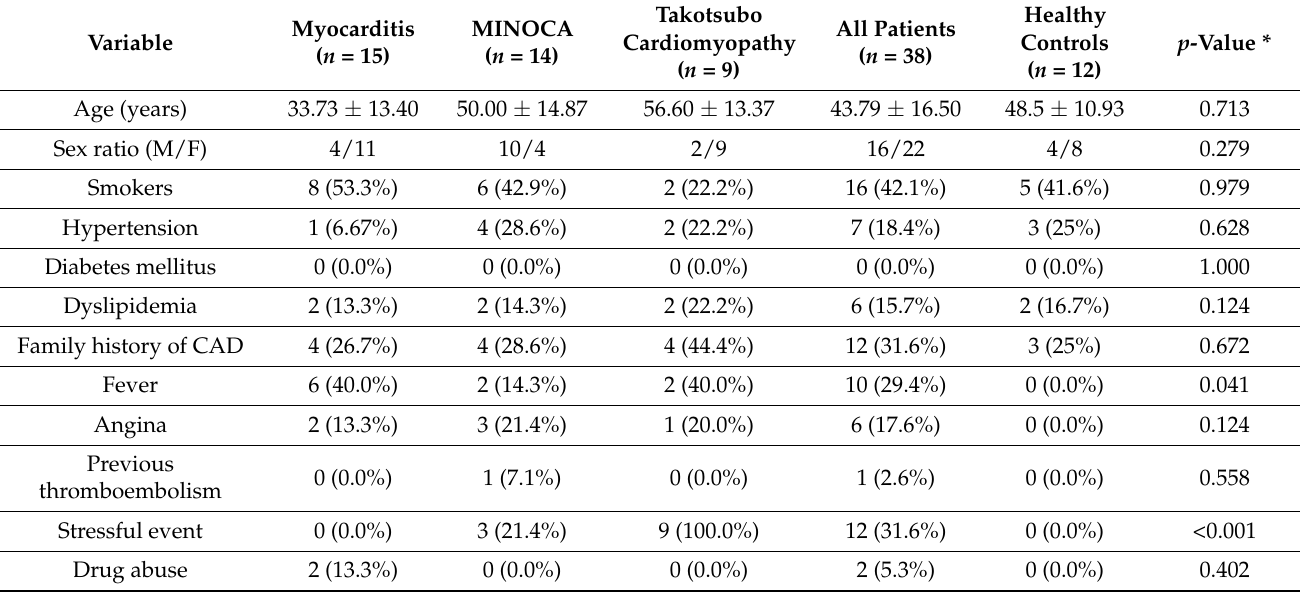
Table 1. Clinical and echocardiographic